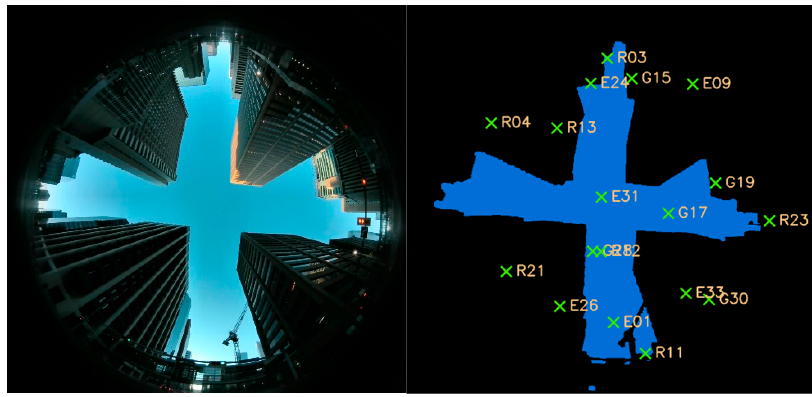
Figure 6. Demonstration of upwards fisheye camera based signal visibility ground-truth determination.